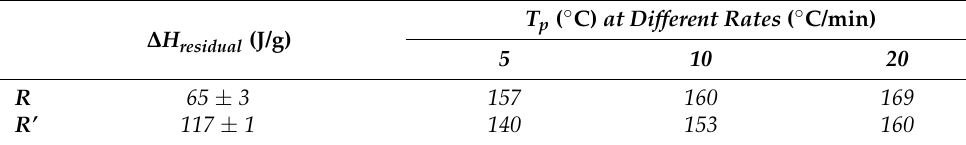
Table 9. Residual enthalpy and curing peak of R and R’ after UV exposure. ∆ H residual